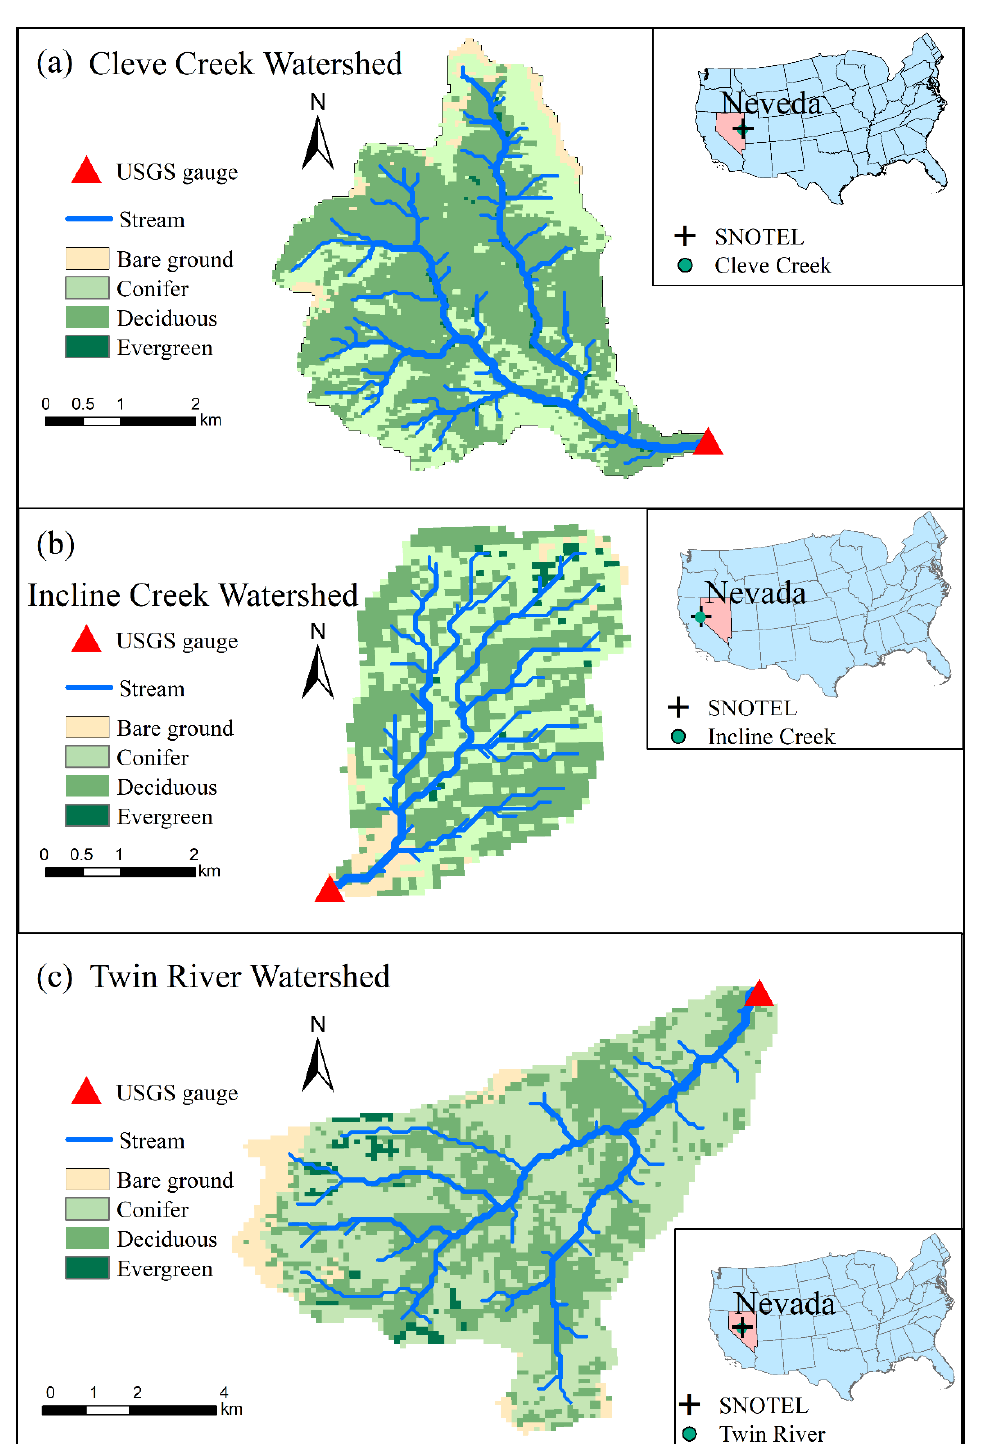
Figure 1. Three mountain watersheds located in Nevada in the western United States Great Basin and the stream gauge locations in the watersheds.